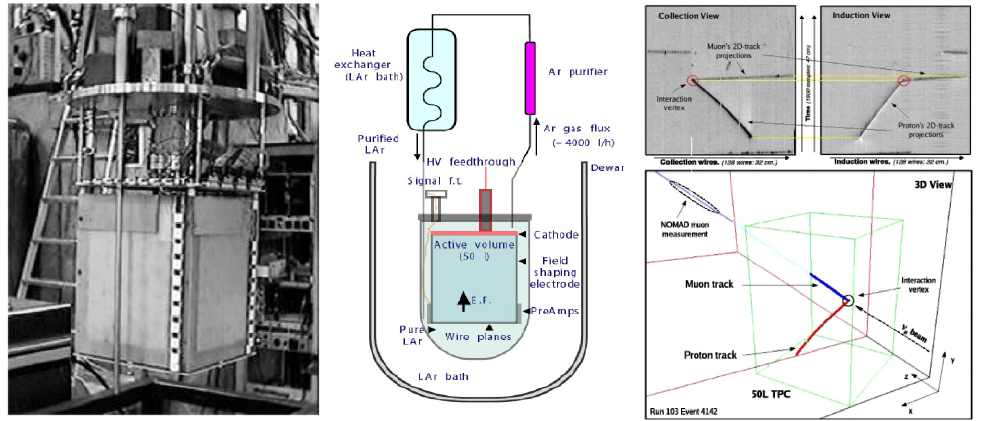
Figure 4. ( Left ): The 50 liters LAr-TPC detector mounted on its large feed-through flange. Center: Sketch of the overall apparatus. ( Right ): An example of Quasi-Elastic ν µ CC event observed both in Induction and Collection wires planes, as well as its 3D reconstruction.